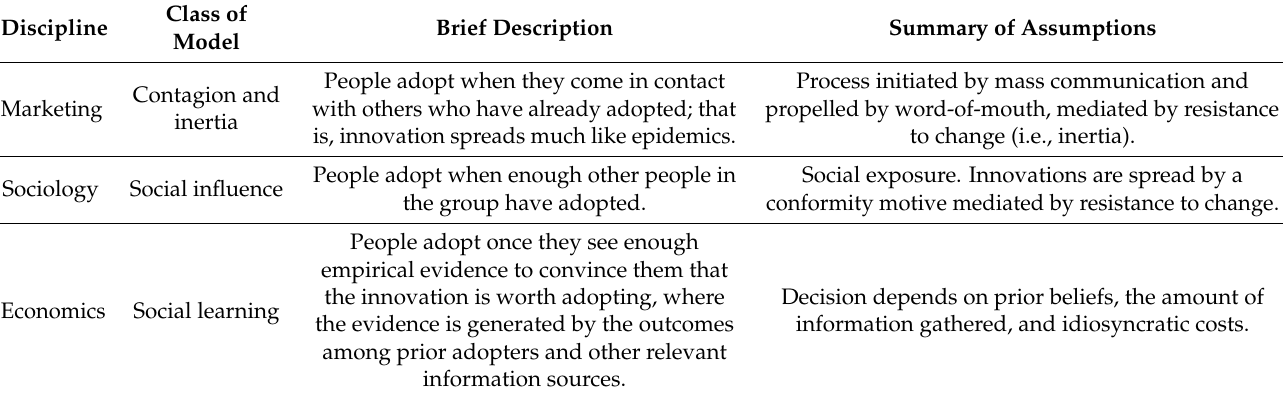
Table 1. Comparison of three classes of models of innovation adoption. Based on Young [24].